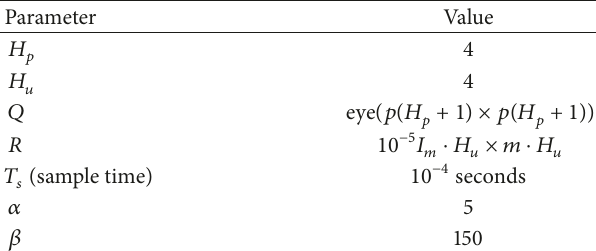
Table 3. Table 4 describes the nomenclature of control